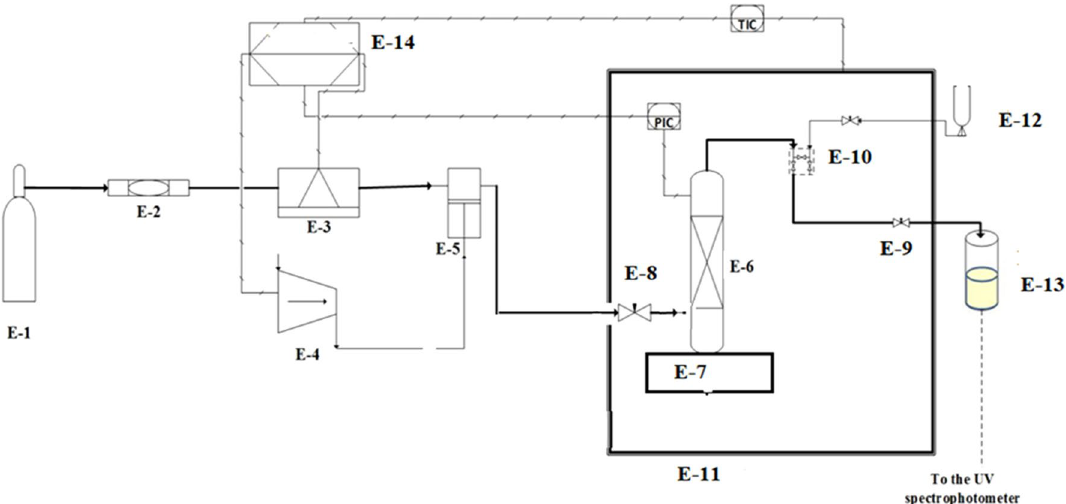
Figure 1. Experimental setup for solubility measurement, E1—CO 2 cylinder; E-2—Filter; E-3—Refrigerator unit; E-4—Air compressor; E-5—High pressure pump; E-6—Equilibrium cell; E-7—Magnetic stirrer; E-8— Needle valve; E-9—Back-pressure valve; E-10 Six-port, two position valve; E-11—Oven; E-12—Syringe; E13— Collection vial; E-14—Control